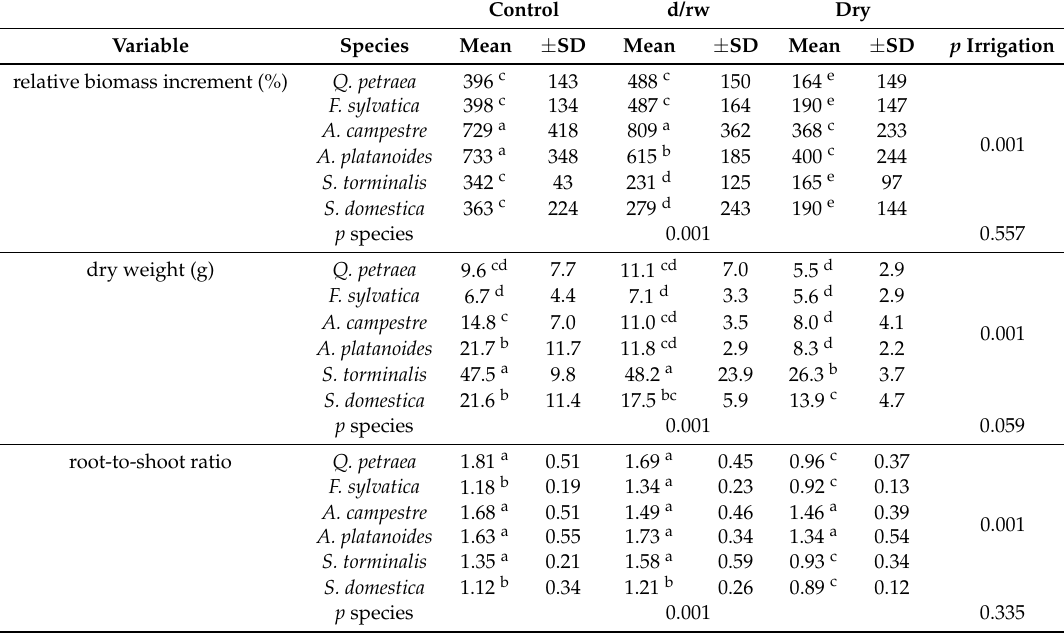
Table 3. Means and standard deviation ( ± SD) of relative biomass increment, absolute dry weight of the seedlings at the end of the experiment, and the root-to-shoot ratios for plants of the control, drying/rewetting (d/rw), and dry treatment groups, where fresh plant mass at the beginning of the experiment was 100%. Different letters indicate significant differences between species and irrigation regimes ( p < 0.05), n = 18 per tree